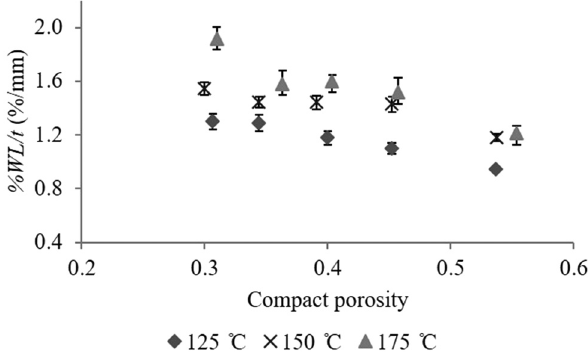
Figure 8: Relations between average values of % WL/ t of compacts and compact porosity before heat treatment at di ff erent heat treatment temperatures. Error bars represent ± standard devia - tion, n =